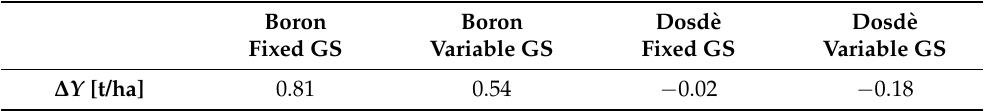
Table 5. Differences in specific productivity between simulation and observation: in situ data were used for the validation of the model in Boron from the year 2003 and in Dosd è , for 2 sites, from the year 2019.